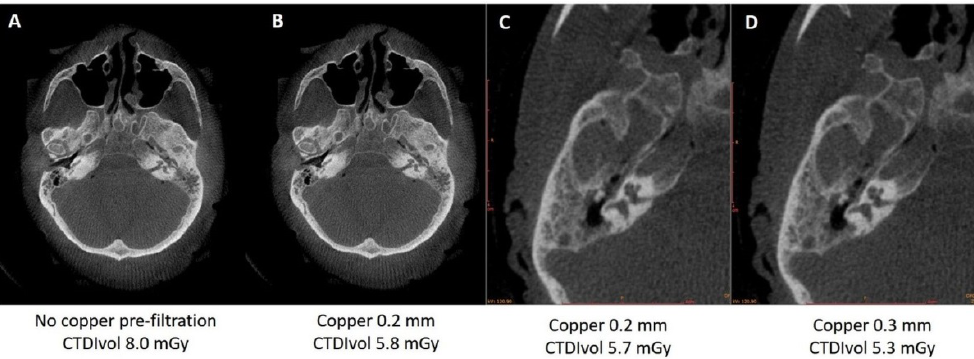
Figure 4. Comparison of datasets (121 kV / DL 1090) without ( A ) und with 0.2 mm copper ( B , C ), respectively 0.3 mm copper pre-filtration ( D ). Despite decreasing radiation exposure, pre-filtering with copper shows no deterioration in the image quality in the head overview ( A , B ) or in terms of the recognisability of details ( C , D ).